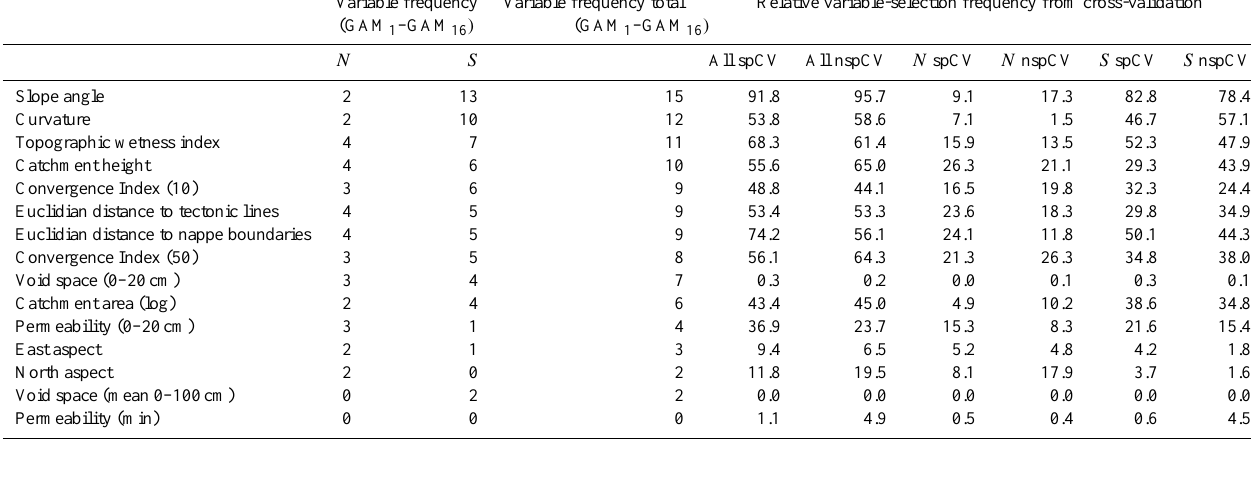
Table 2. Variable frequency for the model using all landslide cells (GAM 1 –GAM 16 ) and variable-selection frequency of variables used linearly ( N ) or with a smoothing function ( S ) in spatial (spCV) and non-spatial (nspCV) cross-validation. All values are summarized over all modelling domains.